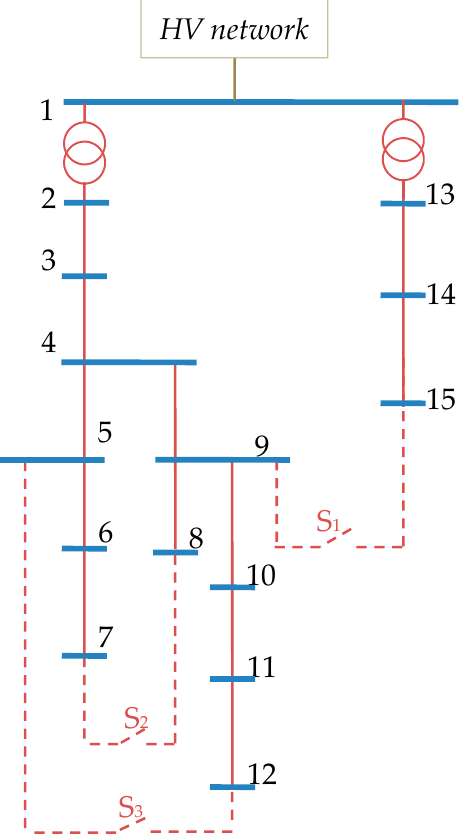
Figure 3. The microgrid under study. Table 2. Load Input